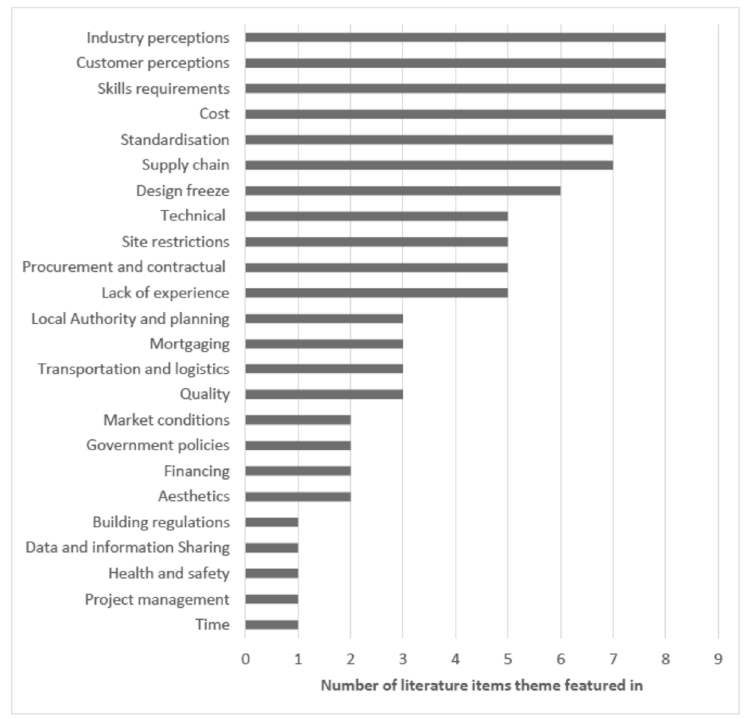
Figure 1. The number of pieces of literature on each barrier theme is featured within the literature.